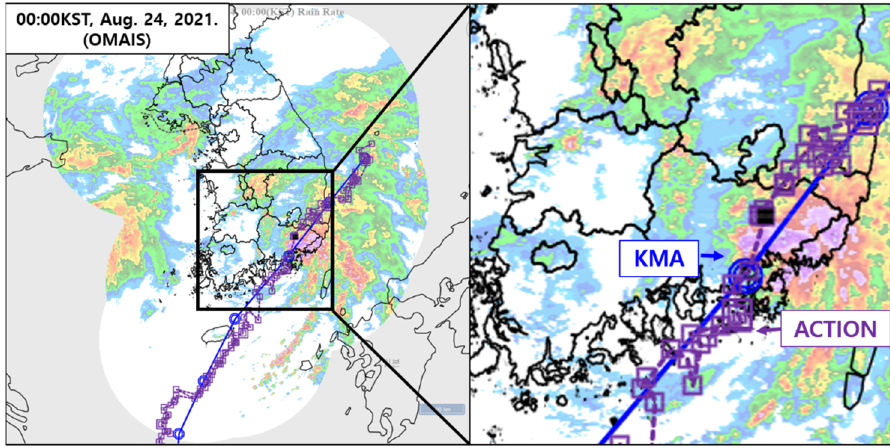
Figure 11. An example of ACTION being operated in real time by the KMA’s radar analysis system (typhoon case of “OMAIS”, occurring at 00:00 KST, 24 August 2021).